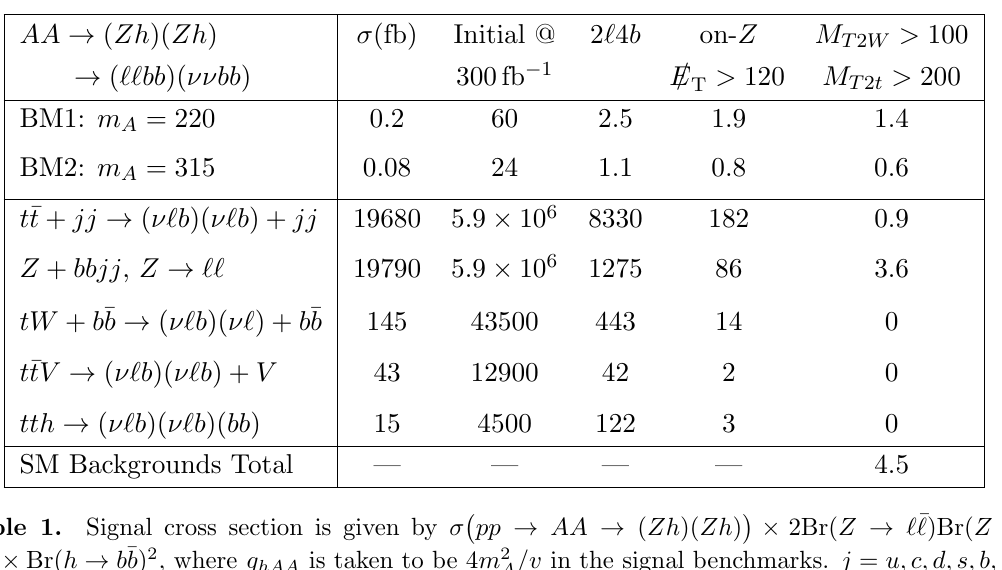
multiple decay channels that can be potentially